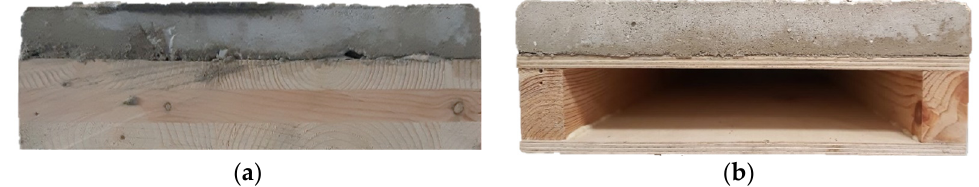
Figure 2. Cross-section of timber–concrete composite (TCC) with: ( a ) cross-laminated timber (CLT); ( b ) plywood rib panel.